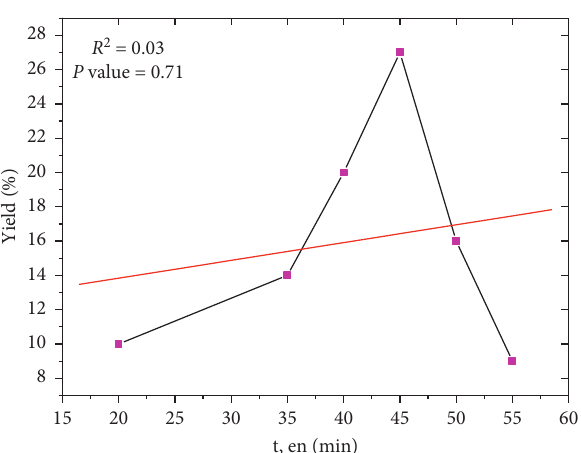
Figure 1: Effects of extraction time on yield of